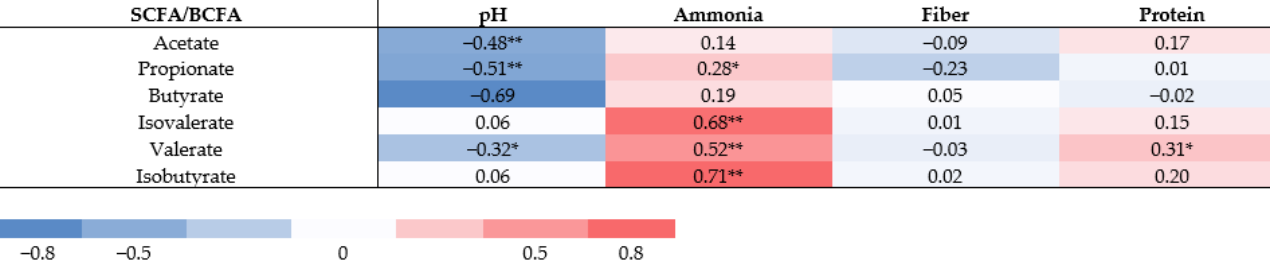
Figure 6. Spearman correlation between SCFA/BCFA concentrations, fecal metabolic markers, and dietary variables. Correlation presented with Spearman correlation coefficient. Significant differences marked with asterisks (** p = < 0.0001, * p ≤ 0.05).